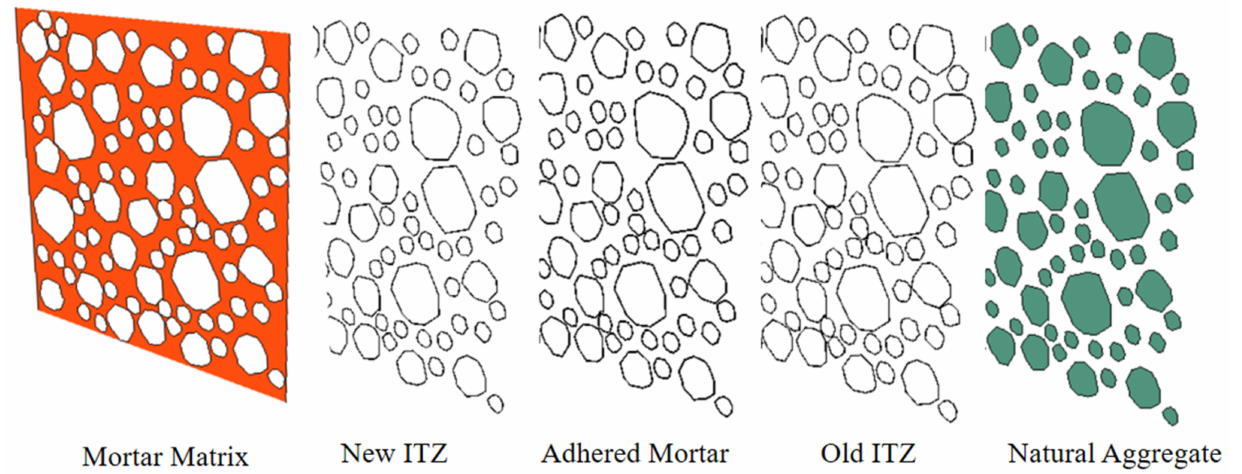
Figure 3. The element components for a 2D meso-model of RAC